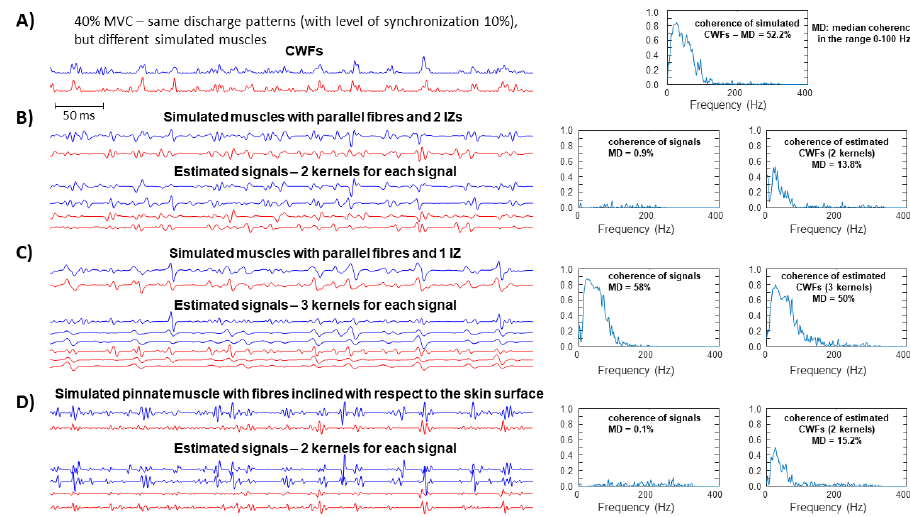
Figure 4. Example of the estimation of coherence in different conditions. The same firings were generated and then applied to simulate different EMGs considering different sets of MUAPs obtained using three models. A contraction level of 40% MVC was simulated, considering a volume conductor with fat layer thickness of 3 mm, mean CV of 4 m/s, CoV of ISI 10%, maximum FR 40 Hz, and level of synchronization between MU firings of 10%. MUs were randomly split into two sets, used to generate two EMGs (as they were recorded by two SD channels, each one placed over one of the two different muscles, each constituted by 200 MUs). ( A ) Simulated CWFs of the two muscles (portion of half a second on the left) and coherence (right, considering signals of 10 s duration). ( B ) EMGs of two muscles with two IZs (left, same time range as for the CWFs in ( A ) and estimated coherence (right), using either the raw signals or the estimated CWFs using two kernels with opposite phase, for each muscle. ( C ) Same as ( B ), but considering a signal with a single IZ and three kernels for the deconvolution. ( D ) Same as ( B ), but considering a simulated volume conductor with fibres inclined of 25 ◦ with respect to the skin surface.